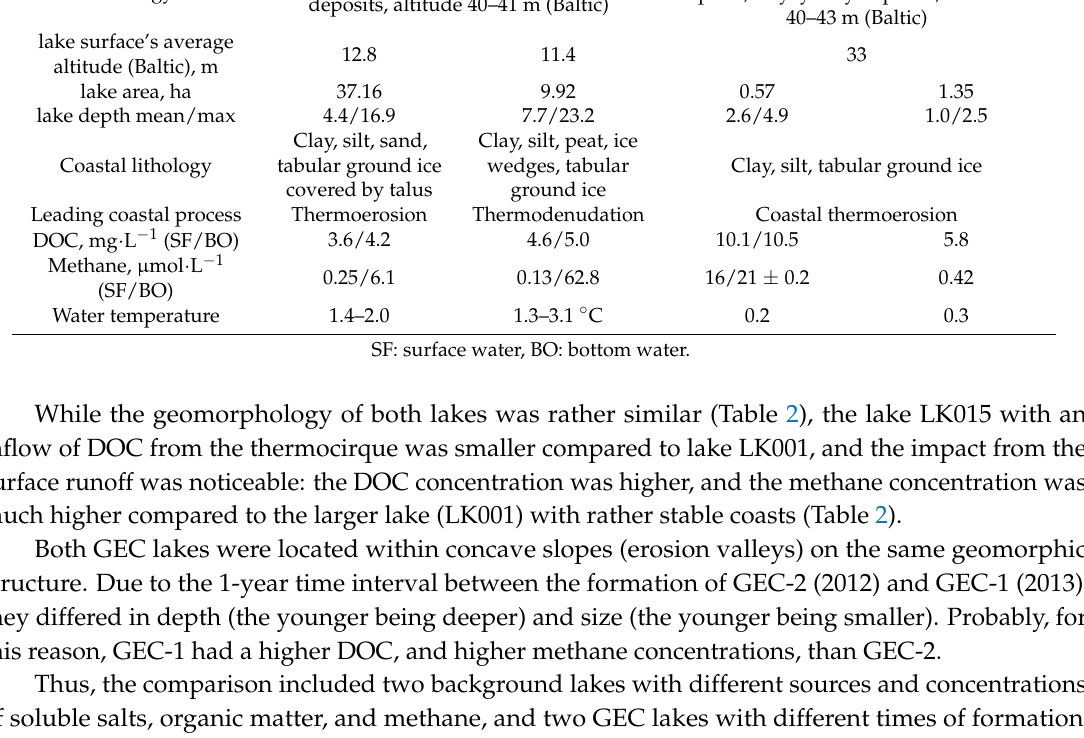
Table 2. The parameters of the sampled lakes (LK001, LK015, GEC-1, and GEC-2) in April 2018. Parameter LK001